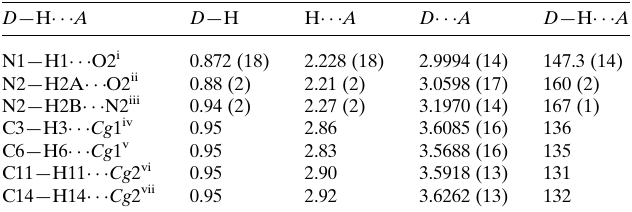
Table 2 Hydrogen-bond geometry (A˚ , (cid:3) ) for